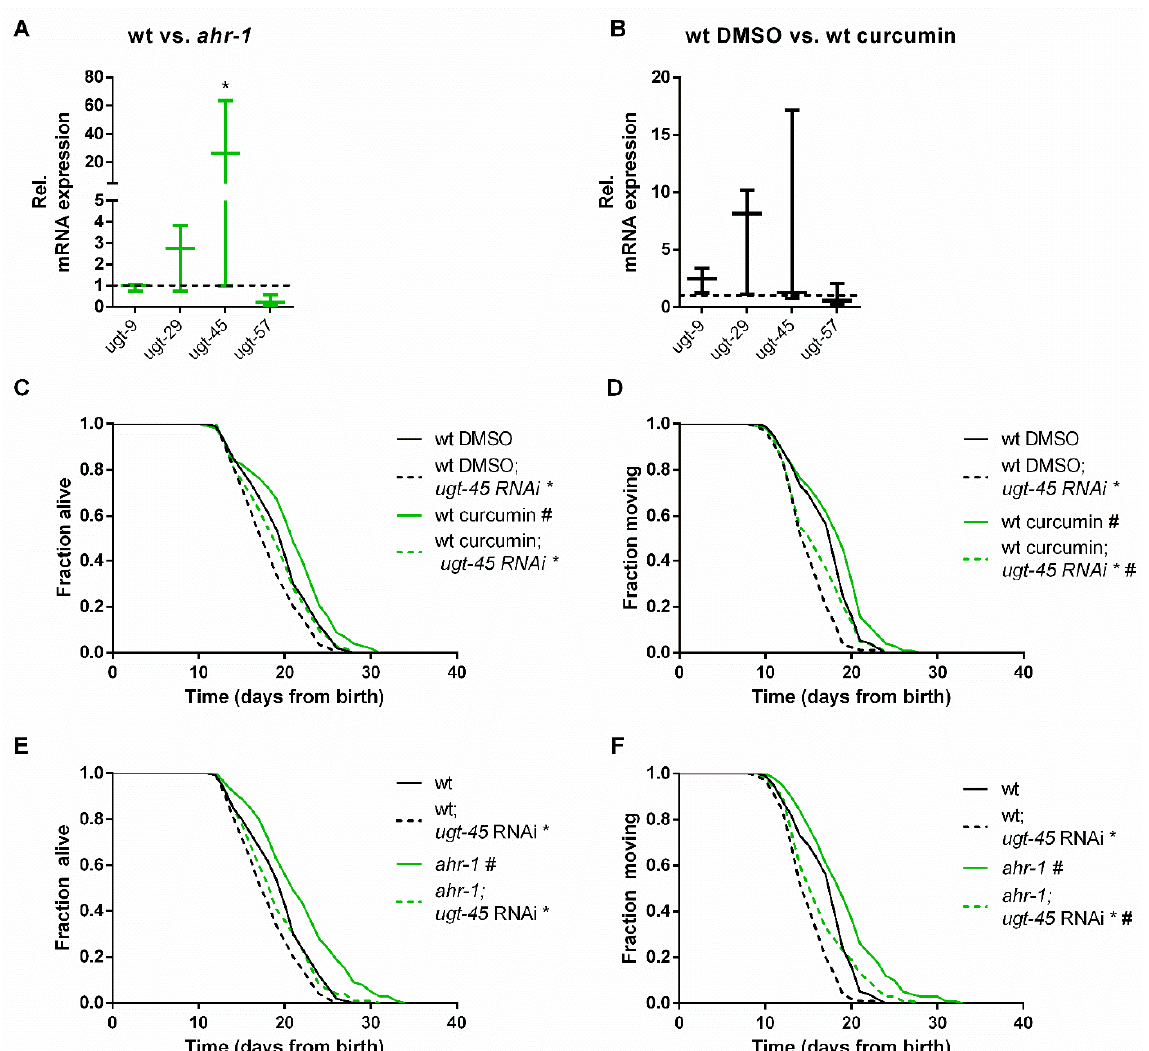
Figure 3. ugt-45 is required for the lifespan extension of curcumin and ahr-1 mutants. ( A , B ) Gene expression was assessed by qPCR in wt vs. ahr-1 ( A ) and DMSO- vs. curcumin-treated wt nematodes ( B ). Boxplots show data of 3 experiments. The expression is shown relative to DMSO-treated wt (indicated as dashed line). Statistical test: 2-Way ANOVA with Sidak’s multiple comparisons test, * p -value < 0.05 vs. wt, # p -value < 0.05 vs. DMSO. ( C , D ) Effect of ugt-45 RNAi on the curcumin-mediated life/health span extension in the wt. Survival curves show pooled data of 120 worms/condition in 2 replicates. Statistical test: Log-Rank test, # significance vs. DMSO, * significance vs. control RNAi, Bonferroni p -value < 0.05. ( E , F ) Effect of ugt-45 RNAi on ahr-1 -mediated life/health span extension. Survival curves show pooled data of 120 worms/condition in 2 replicates. Statistical test: Log-Rank test, # significance vs. wt, * significance vs. control RNAi, Bonferroni p -value < 0.05.